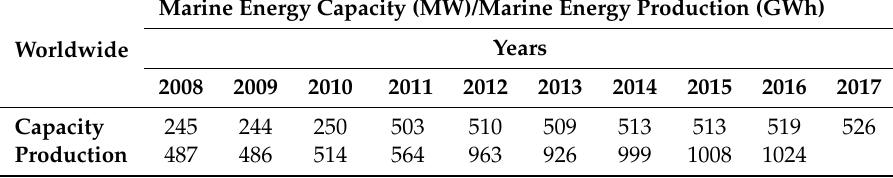
Table 1. Marine electricity capacity/production worldwide